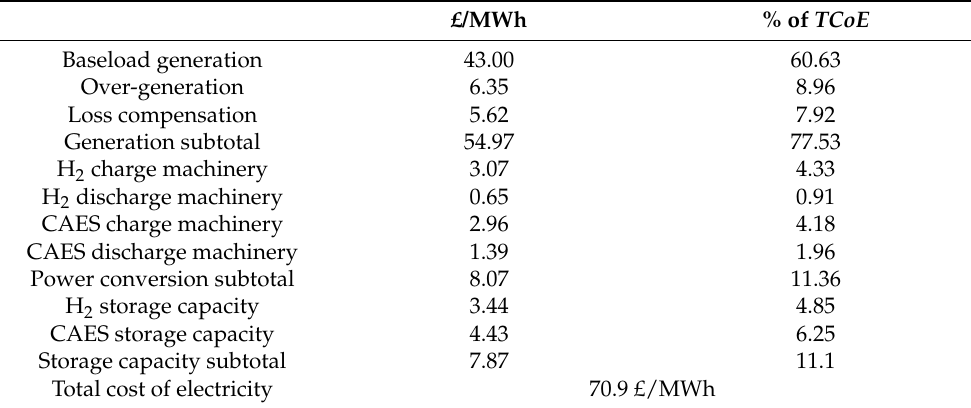
Table 3. Individual contributions of different system components to the TCoE in the optimum system configuration ( X =